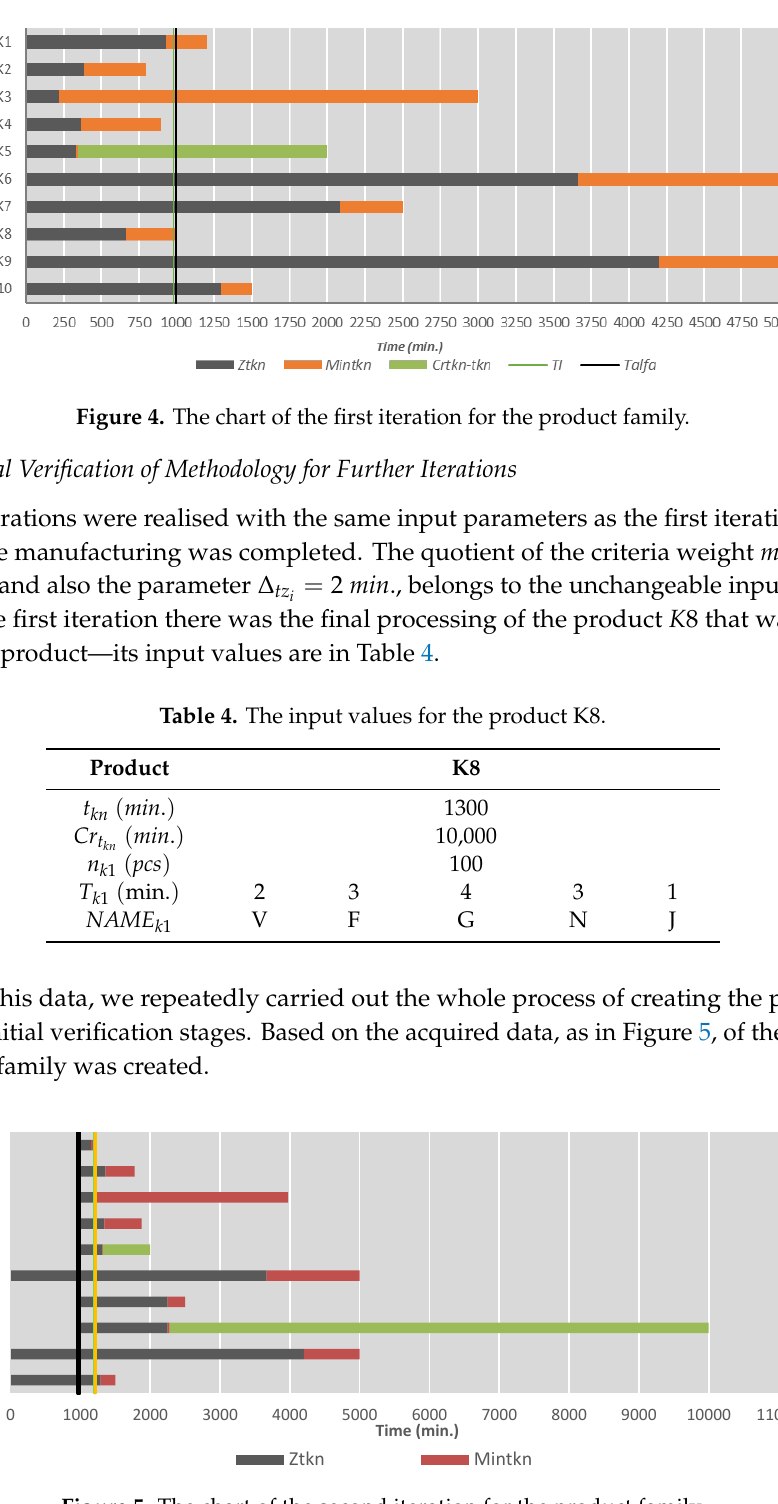
Figure 5. The chart of the second iteration for the product family.